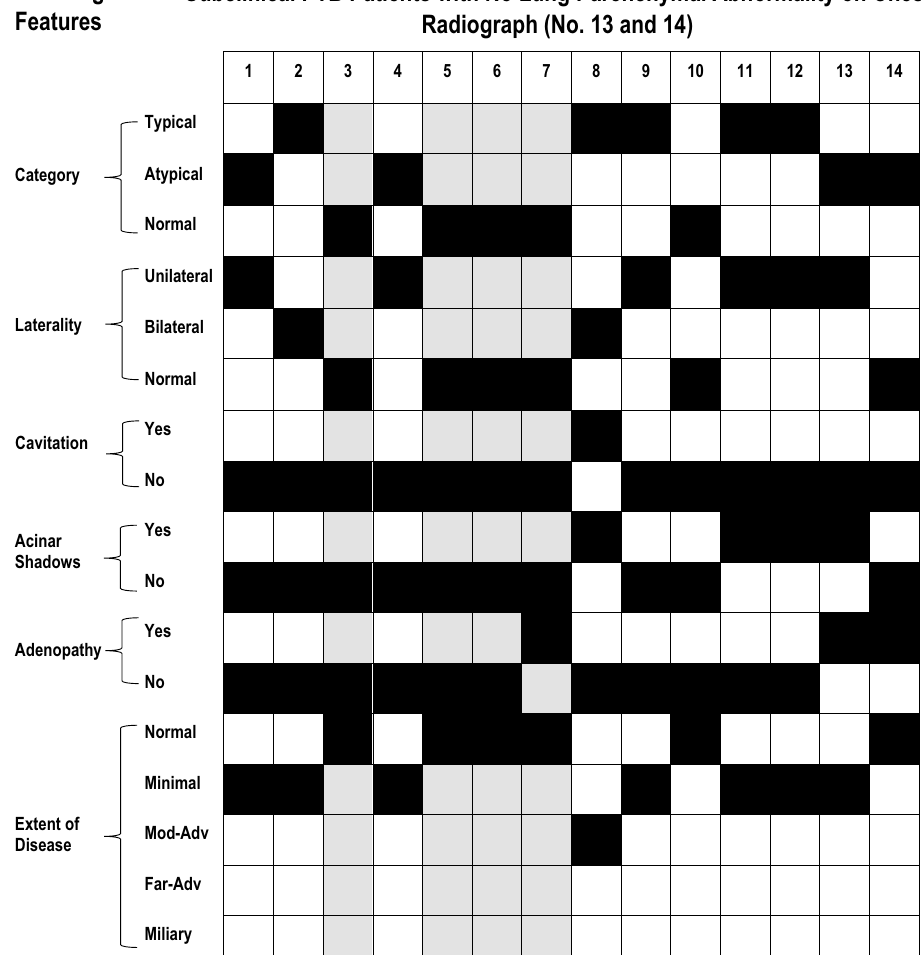
Figure 3. Computed tomographic (CT) scan results in patients who had normal chest radiographs (patients #1–12) and in patients whose chest radiographs were abnormal but showed no lung parenchymal abnormality (patients #13 and 14). Positive findings are indicated by a black box . Back-shaded columns (3, 5, 6, 7) refer to patients who had a CT scan of the neck. Patients #3, 5, 6, 7, and 10 had concomitant cervical lymph node TB. Patients #9 and #12 were close contacts of smear-positive clinical patients. In Patient #8 (i.e. the patient whose chest radiograph was reported as normal and whose CT was reported as showing moderately advanced cavitary disease) the chest radiograph and CT scan were performed on the same day. Abbreviations: CXR chest X-ray; MOD moderately; ADV